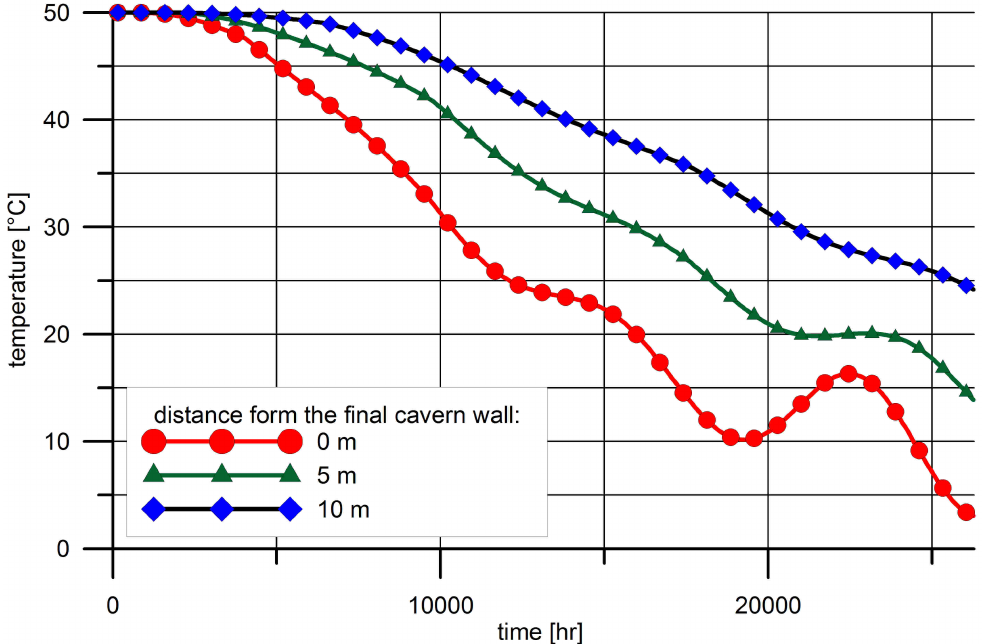
Figure 6. Temperature distribution over time on the target cavern wall and within the rock salt massif—the model in which leaching begins in